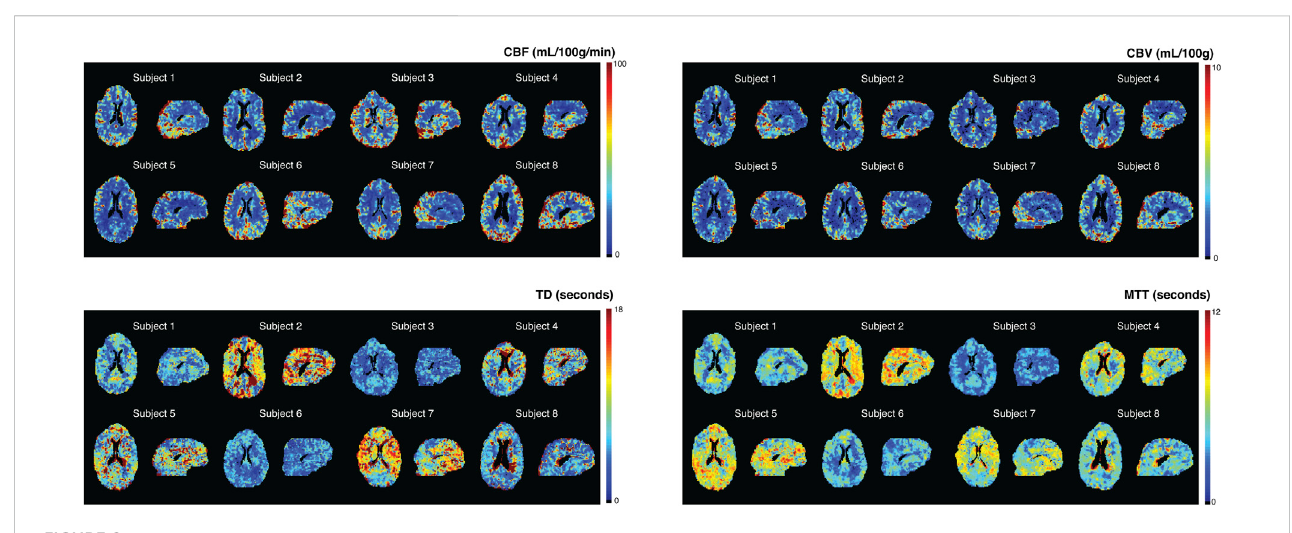
FIGURE 2 SineCO 2 CBF, CBV, TD, and MTT maps for individual